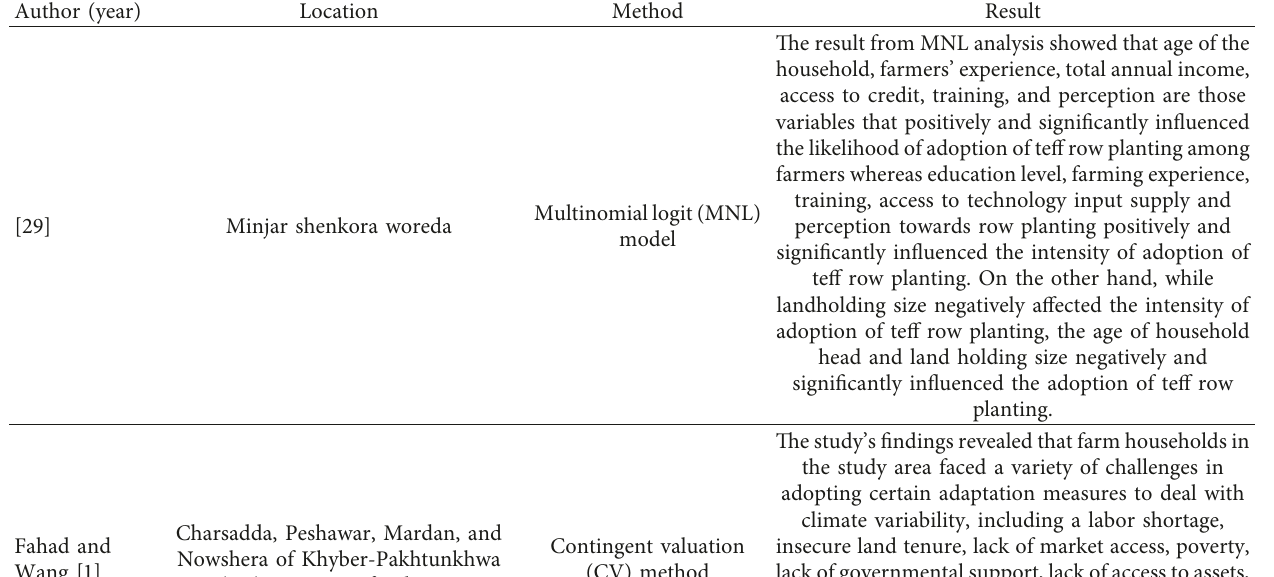
Table 1: Empirical literature